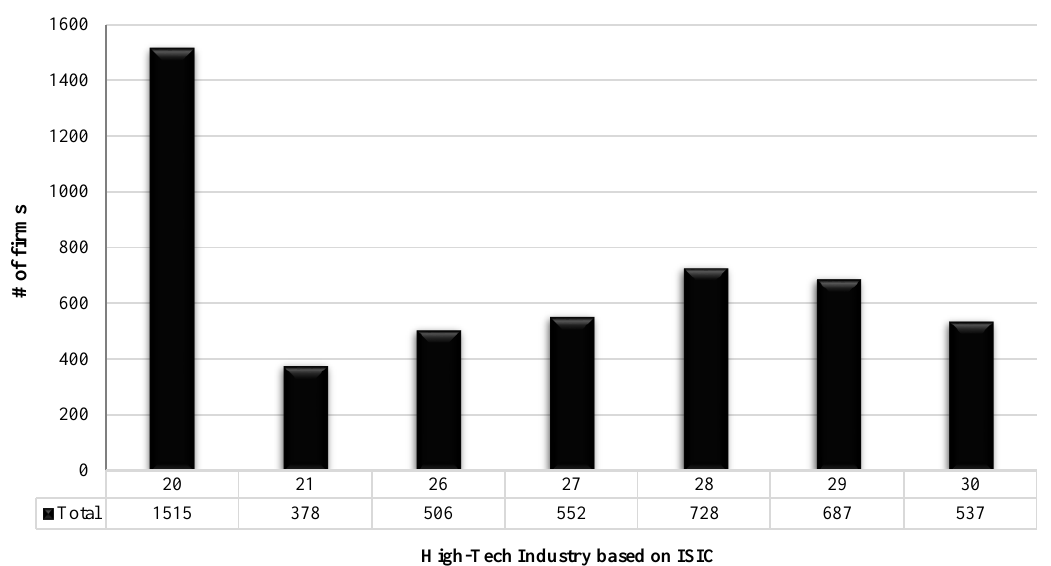
Figure 4. Indonesia's High-tech industry 2017